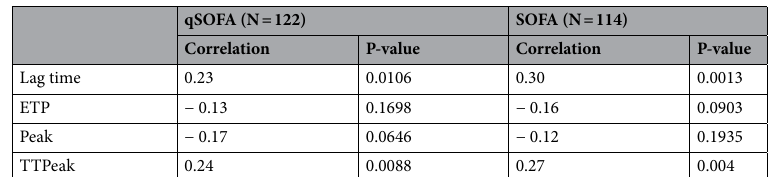
(Table 4). The predictive abilities of TG parameters and the high qSOFA and SOFA scores were investigated using ROC curves and are presented in Fig. 2. For qSOFA, the ROC curve showed an area under the curve (AUC) of 64% for lag time and 65% for TTpeak. For SOFA ≥ 2, the ROC curve showed an AUC of 65% for lag time, 63% for ETP and 63% for TTpeak. Eleven patients died during hospitalization (9%). These patients had lower ETP (1,648 vs. 1,928 nM*min; p = 0.034) and peak height values (284 vs. 345 nM; p = 0.012), and a longer time-to-peak value (8.1 vs. 7.1 min; p = 0.052) than the survivors (Table 5). The ROC curves for TG and mortality showed an AUC of 67.9% for ETP, 73.4% for peak height, 90.1% for qSOFA and 86.4% for SOFA (Fig. 3). Combining the SOFA score and TG values did not result in a significantly better predictive ability, with an AUC of 0.868 for SOFA and ETP, and 0.878 for SOFA and peak height.